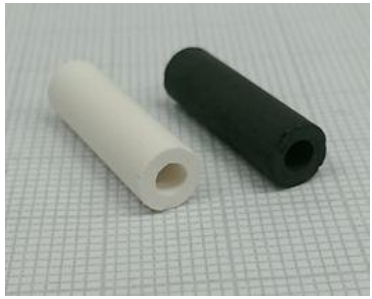
Figure 11. Binderless zeolite-made tube and the according carbon replica (one small square of the pad corresponds to 1